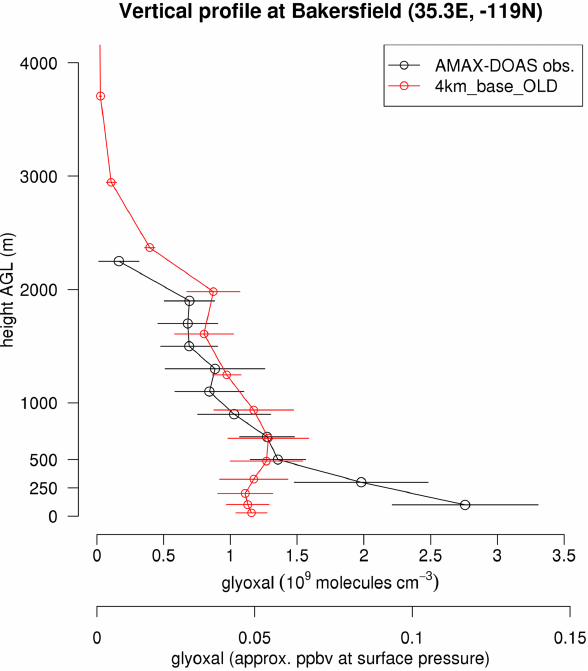
Figure 7. Comparison against vertical profiles of glyoxal as mea- sured by AMAX-DOAS (black) on 15 June (low approach over Bakersfield (Baidar et al., 2013b) at about 21:25–21:40UTC. As- cent and descent averaged 1 σ level errors). Model (red) error bars are 1 standard deviation of the 3hourly values (11:00, 12:00,